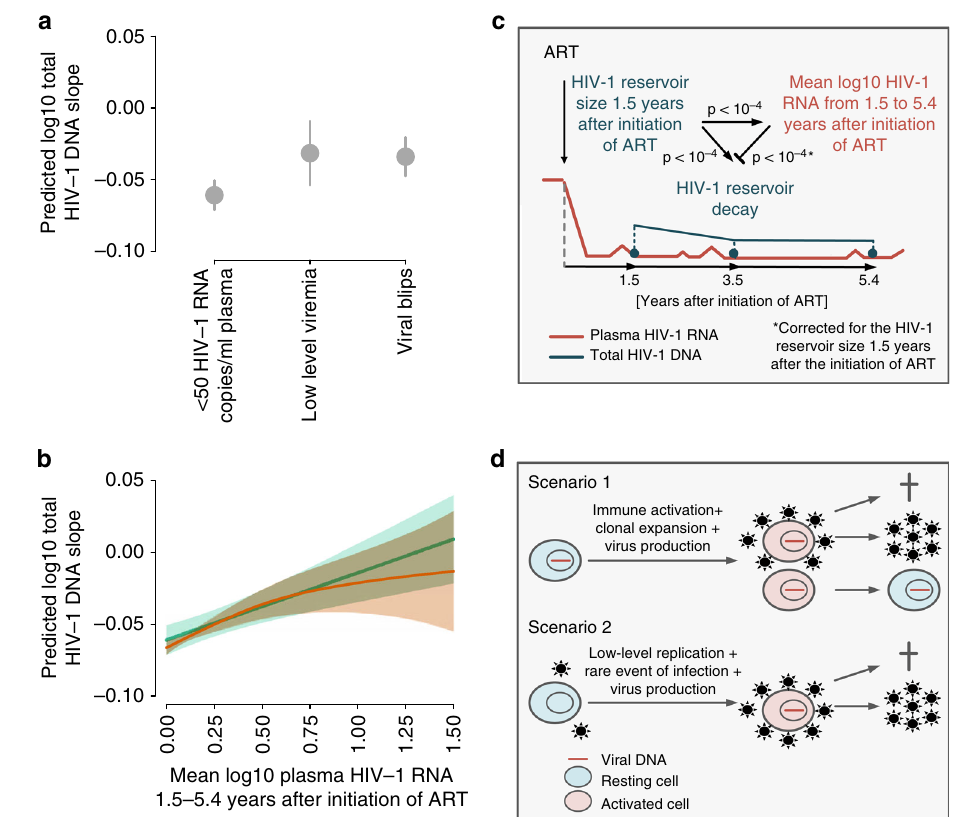
Fig. 4 The interplay of residual viremia and HIV-1 reservoir size and long-term dynamics. a The predicted log10 total HIV-1 DNA slope conditional on the effect of all other covariables and the observed viral load (constantly < 50 HIV-1 RNA copies/ml plasma, occurrence of viral blips, or low-level viremia) within 1.5 – 5.4 years after initiation of ART. b The predicted log10 total HIV-1 DNA slope and 95% con fi dence interval conditional on the effect of all other previously included covariables and the observed mean log10 plasma HIV-1 RNA (viral blips and low-level viremia) within 1.5 – 5.4 years after initiation of ART is shown in green. This was calculated using the R-package margins. The result of fi tting a spline as the smoothing function for mean log10 plasma HIV-1 RNA (viral blips and low-level viremia) within 1.5 – 5.4 years after initiation of ART while correcting for the previously included covariables is shown in red. We choose a thin plate regression spline with dimension 20 of the basis. c Conceptual fi gure showing the observed associations between: (i) residual viremia, (ii) the HIV-1 reservoir size 1.5 years after initiation of ART, and (iii) the decay of the HIV-1 reservoir 1.5 – 5.4 years after initiation of ART. Residual viremia captured both, low-level viremia and viral blips, from 1.5 to 5.4 years after initiation of ART and was thus indicated as the mean log10 HIV-1 RNA. Arrows indicate a positive effect size, i.e., an enhancing effect. The blunted arrow indicates an inhibiting effect. p values were derived using linear regression. ART antiretroviral therapy. d Two possible scenarios explaining the interplay between residual viremia and HIV-1 reservoir size and